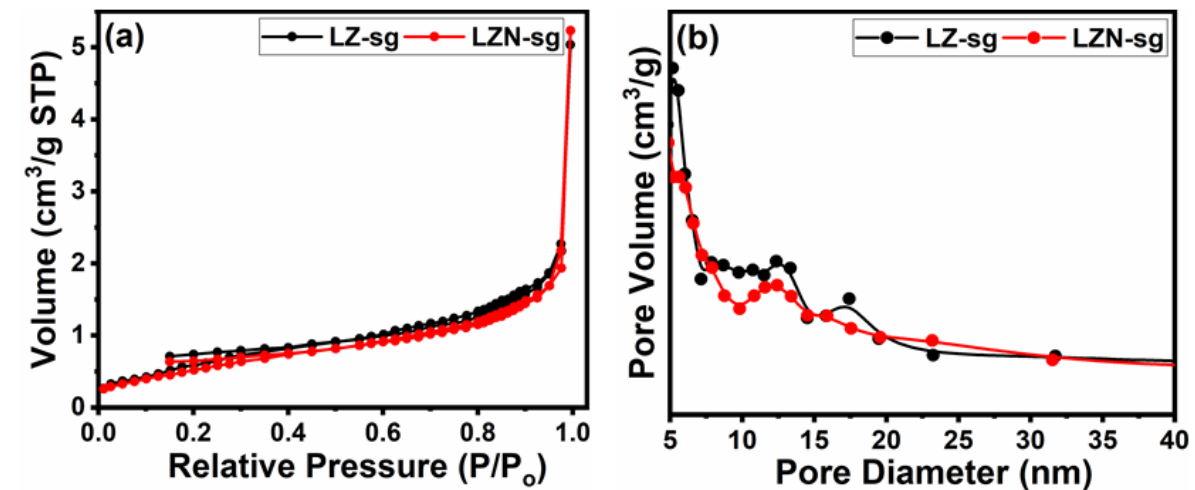
Figure 8. ( a ) BET isotherms; and ( b ) PSD of LZ-sg and LZN-sg pyrochlores. Table 3. Summary of porosity measurements of La 2 Zr 2-x Ni x O 7 pyrochlores.